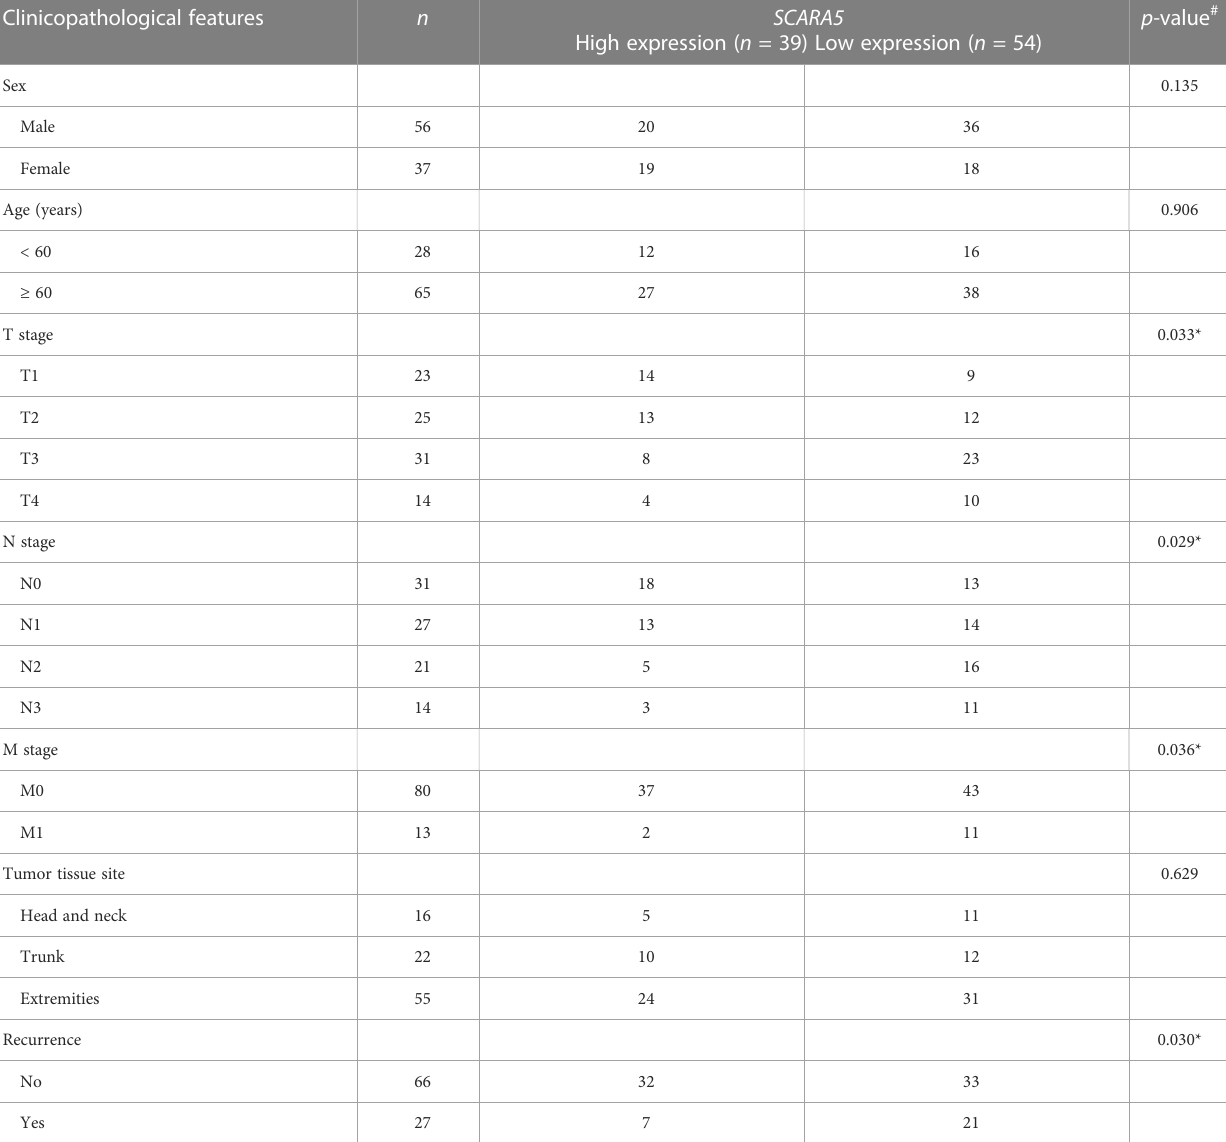
TABLE 4 Association of scavenger receptor class A member 5 ( SCARA5 ) expression and clinicopathological features in melanoma. Clinicopathological